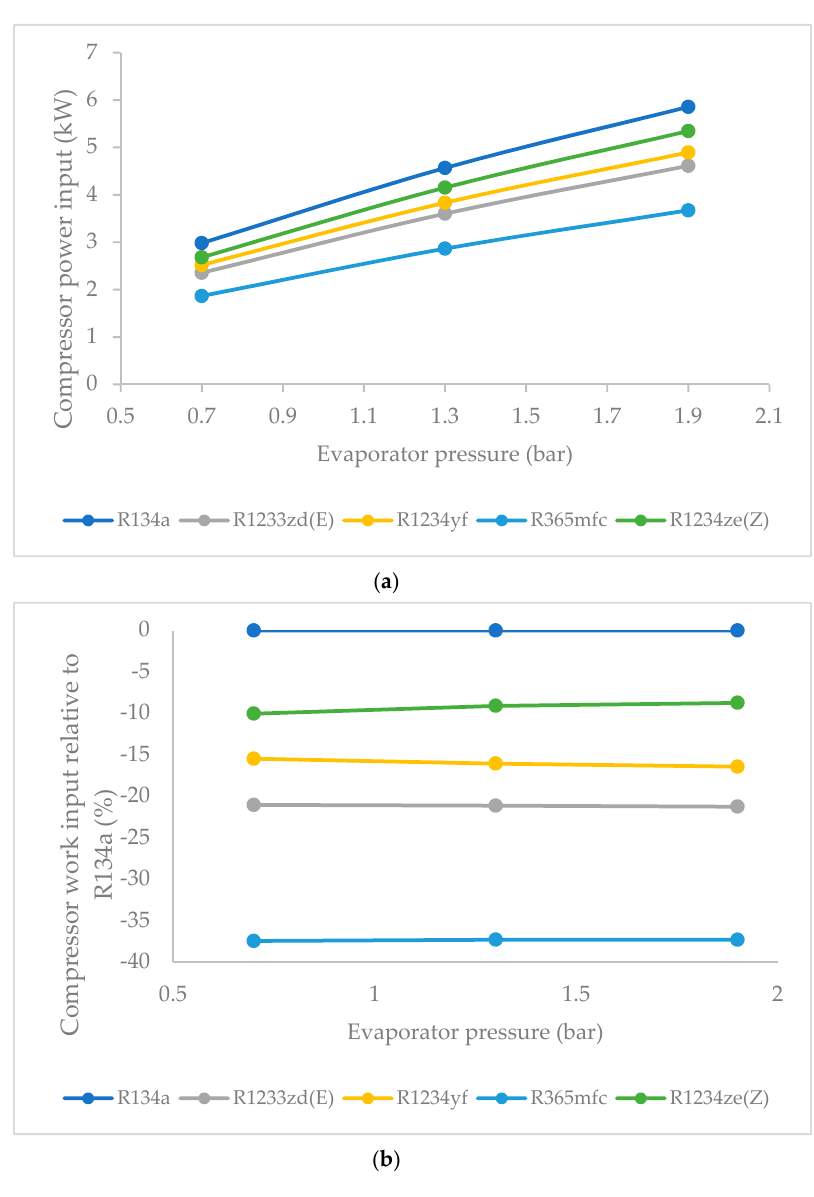
Figure 9. ( a ) Compressor work input as a function of evaporator pressure (condenser pressure = 9 bar). ( b ) Compressor work input relative to R134a (%) (condenser pressure = 9 bar).